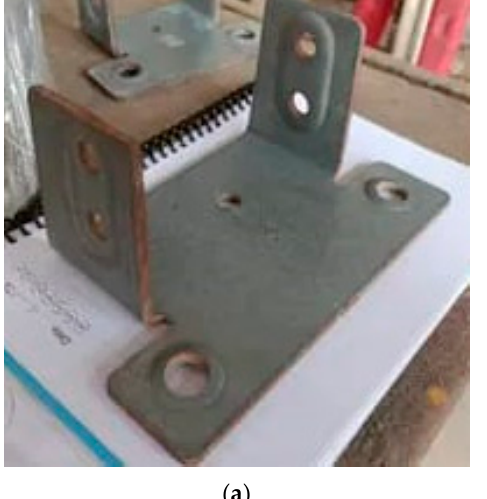
Figure 2. Cross-section geometries and dimensions of the tested specimens. ( a ) Section Dimensions C70-63.5-1.5-P; ( b ) Section Dimensions C90-80-1.5-P; ( c ) Section Dimensions C110-80-1.5-P; ( d ) Section Dimensions C110-80-2-P; ( e ) Section Dimensions C110-80-2.5-P; ( f ) Dimensions of perforations in web and flanges. Table 2. Properties of the tested specimens.